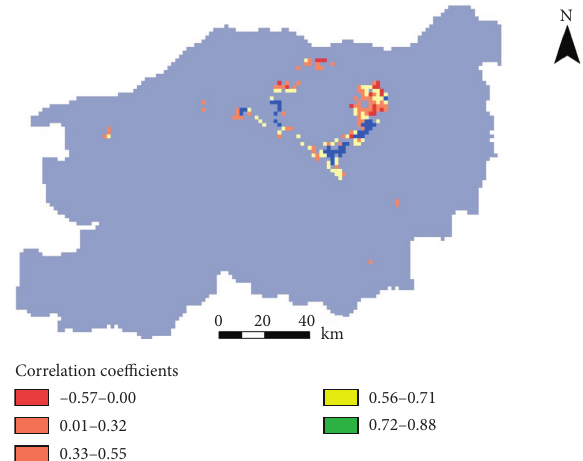
Figure 6: Spatial distribution of the correlation coefficients be- tween NPP and night-time light